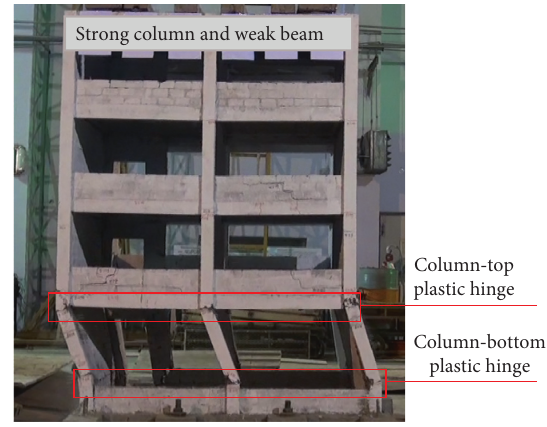
Figure 28: First-floor failure state of the test (front).